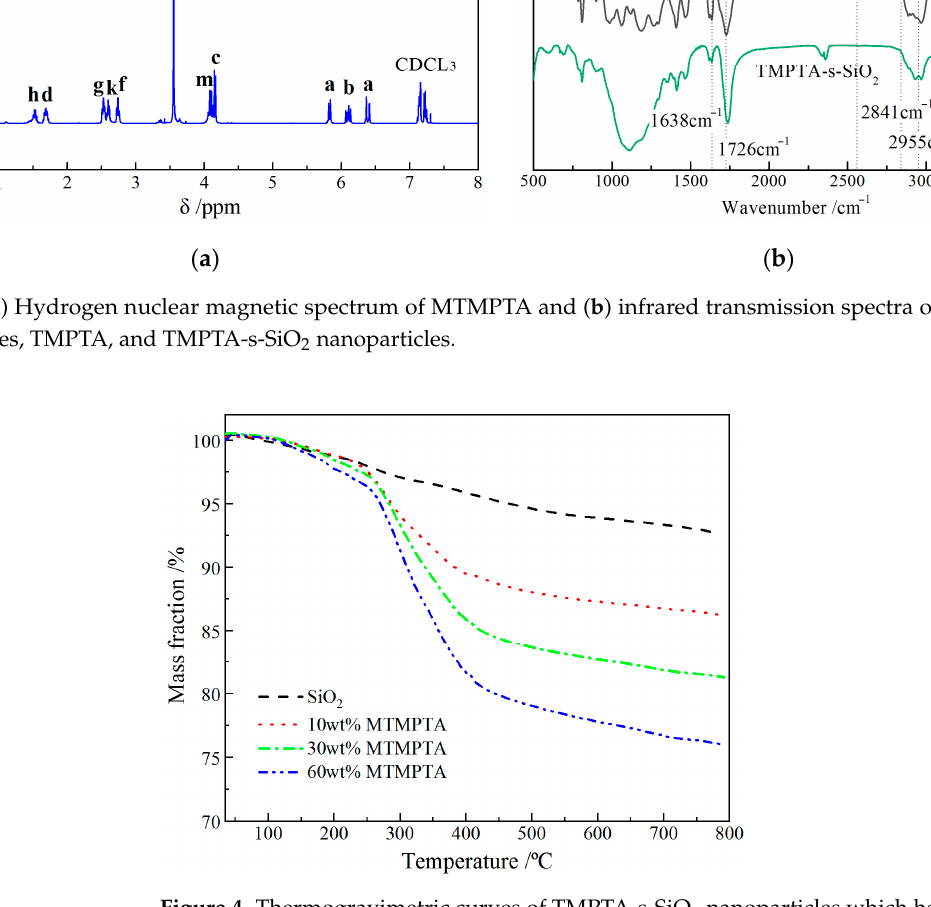
Figure 4. Thermogravimetric curves of TMPTA-s-SiO 2 nanoparticles which have been prepared by adopting different contents of MTMPTA.